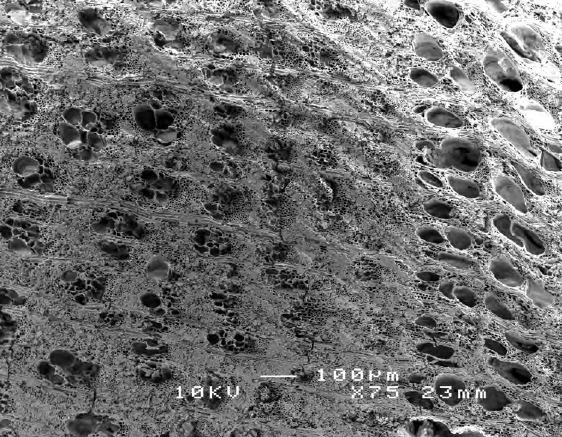
Figure 9: Elm ( Ulmus sp. ), grave 586, cross-section (SEM micrograph: Otto